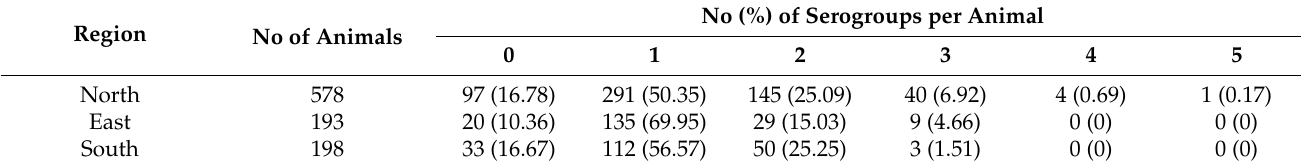
Table 4. Number (No) and percentage of serogroups per animal in the three regions. The percentages refer to the total number of animals tested positive for D. nodosus in the respective regions ( n = 969). No (%) of Serogroups per Region No of Animals